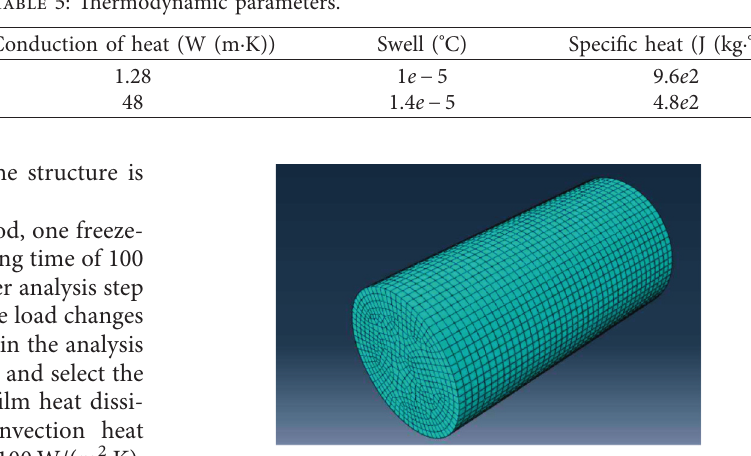
Figure 32: Grid division diagram of the structural